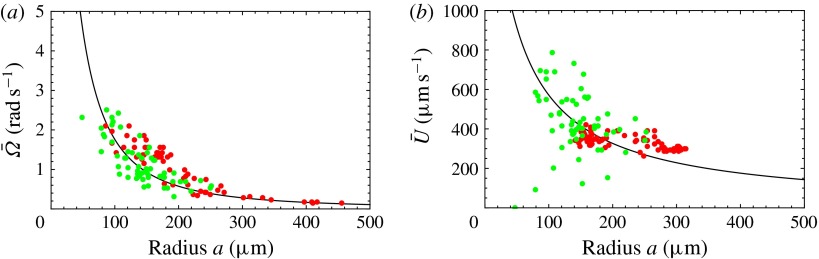
Same as figure 8 but with mean  ().